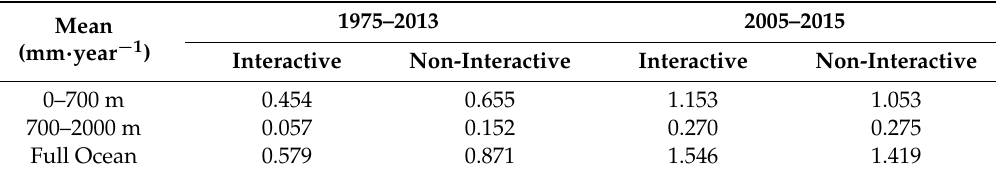
Table 1. Mean steric sea-level rise in Coupled Model Intercomparison Project Phase 5 (CMIP5) models, split into those models that have interactive aerosol chemistry (Interactive), and those that do not